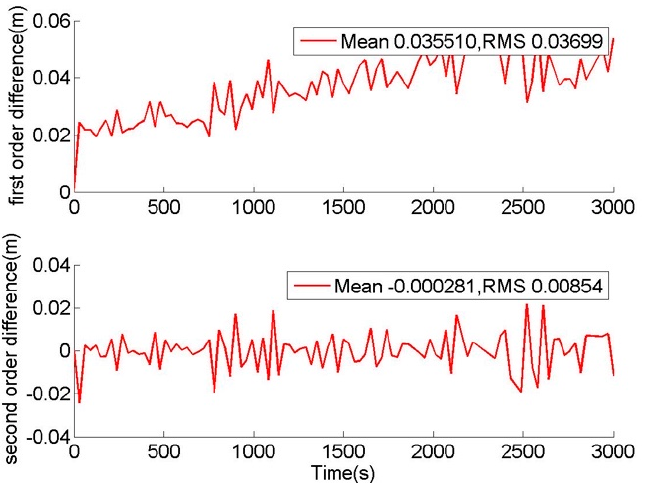
Figure 2. Sequences of the first-order and second-order differences of ionospheric delays during the geomagnetic storm at CUT0 station on GPS satellite 25 starting from UTC 2016/05/08 00:00:00 with an interval of 30 s.